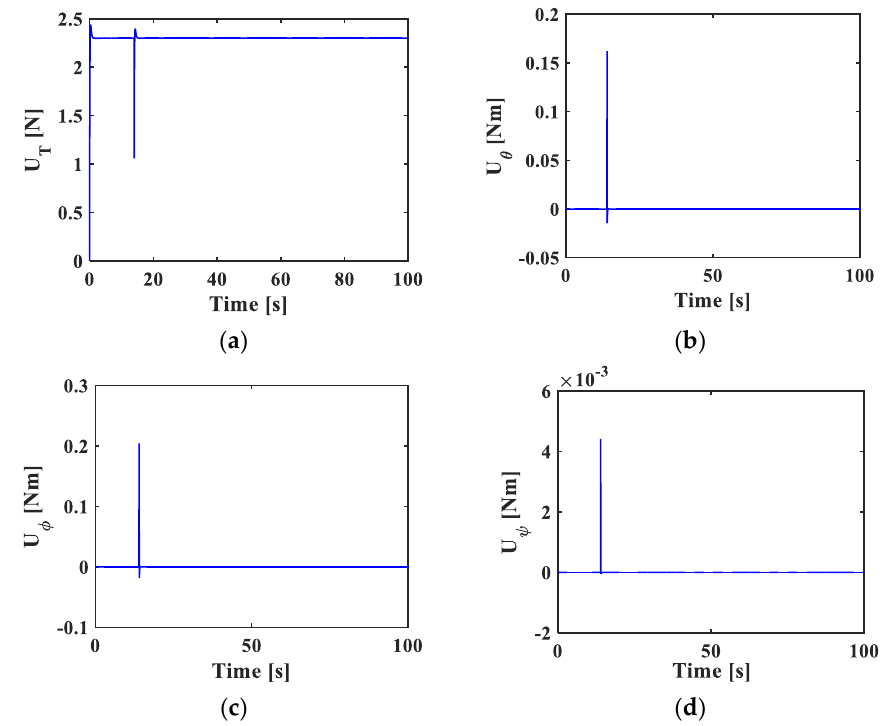
Figure 5. System states in the presence of faults: ( a ) Roll angle, ( b ) Pitch angle, ( c ) Yaw angle, and ( d ) z-direction.